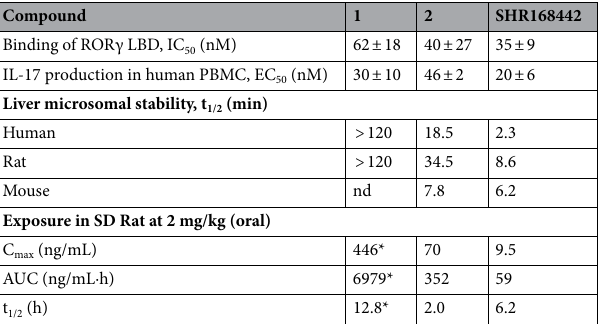
Table 1. The profiles of selected compounds in this work. LBD ligand-binding domain, nd not determined. *Dosed at 5